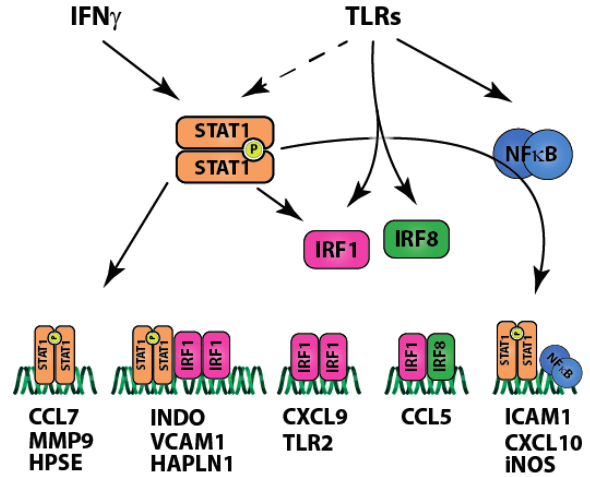
Figure 2. Signal integration between interferon gamma (IFN γ ) and Toll-like receptors (TLRs) involves interactions of STAT1, interferon-regulated factor (IRF)1, IRF8 and nuclear factor kappa-light-chain-enhancer of activated B cells (NF κ B). Analysis of gene expression profiles of atherosclerotic plaques together with the results of microarray experiments conducted by our group on STAT1 -/- SMC [Chmielewski S. et al. ] create this complex signal integration picture (see Discussion). STAT1 regulates genes by itself, but also interacting with IRF1, IRF8 or NF κ